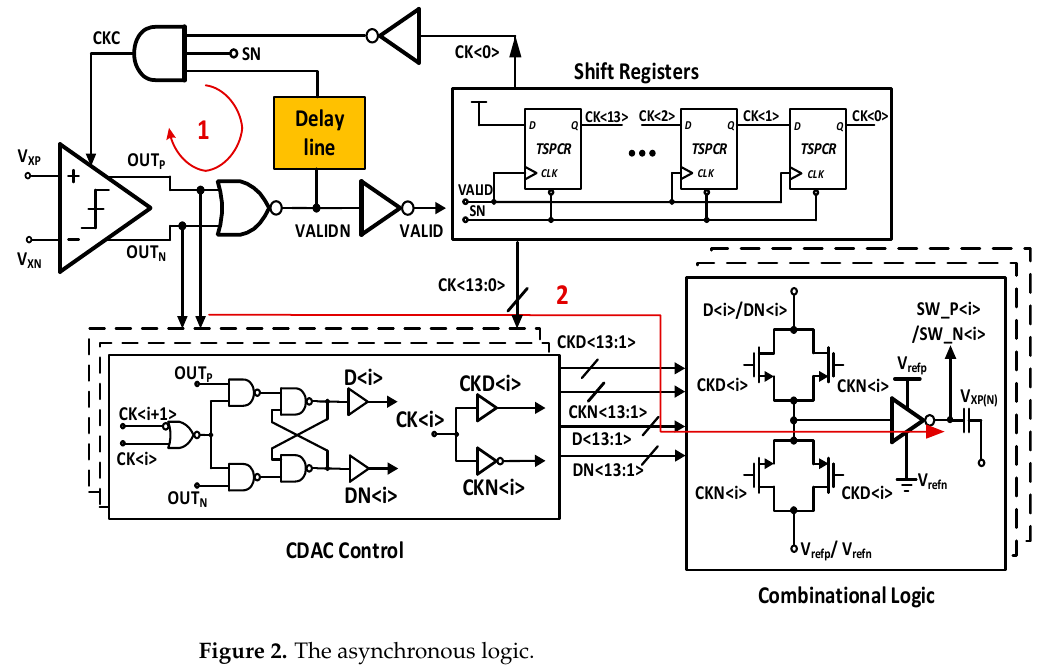
Figure 2. The asynchronous logic.